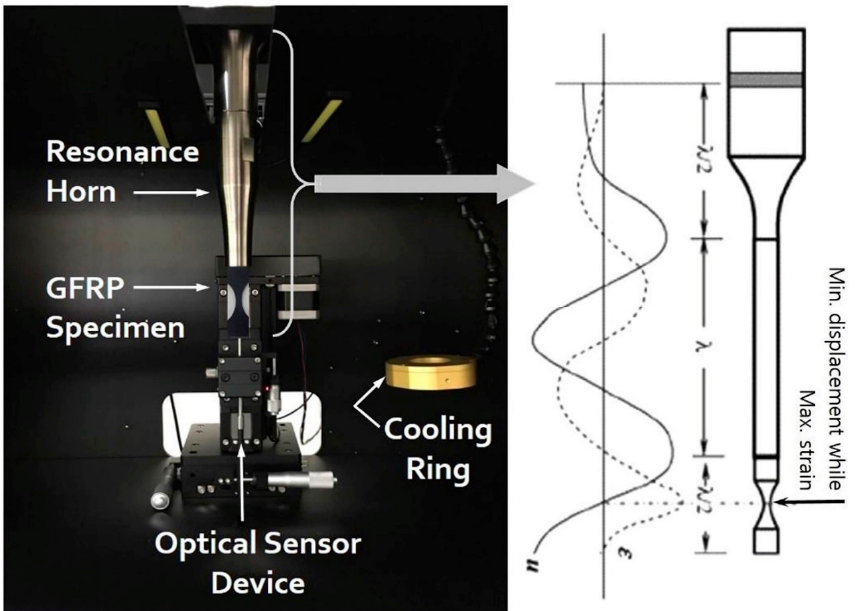
Figure 53. The influence of various load amplitudes and pause times on the surface temperature of a CFRP specimen during cyclic loading at the frequency of 20 kHz during the first minute [65].